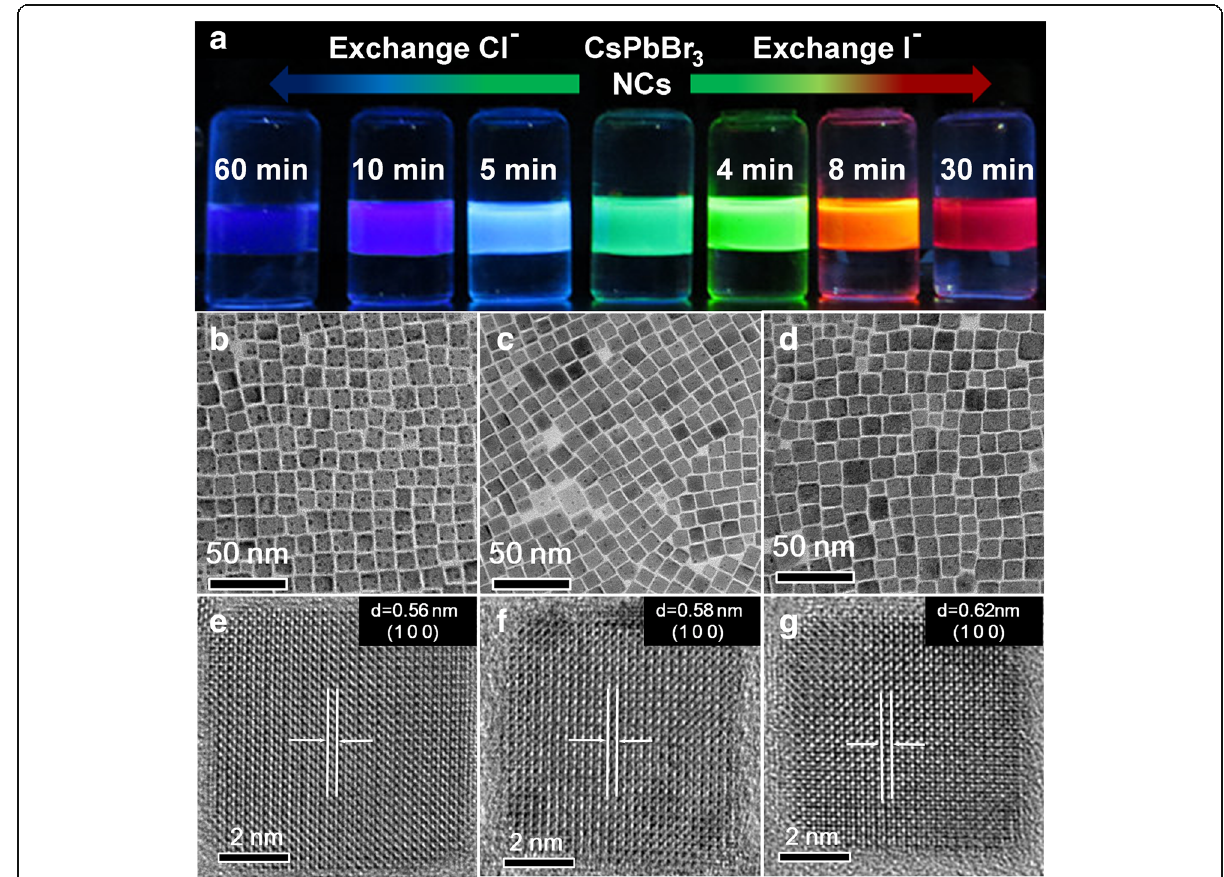
Fig. 3 a Emission photograph of perovskite NCs exchanged with 1 mol/L CsX aqueous solution under 365-nm light illumination. TEM and HR- TEM images of CsPb(Br/Cl) 3 NCs obtained from 60 min exchange ( b , e ), pristine CsPbBr 3 NCs ( c , f ), and CsPb(Br/I) 3 NCs obtained from 30 min exchange ( d , g